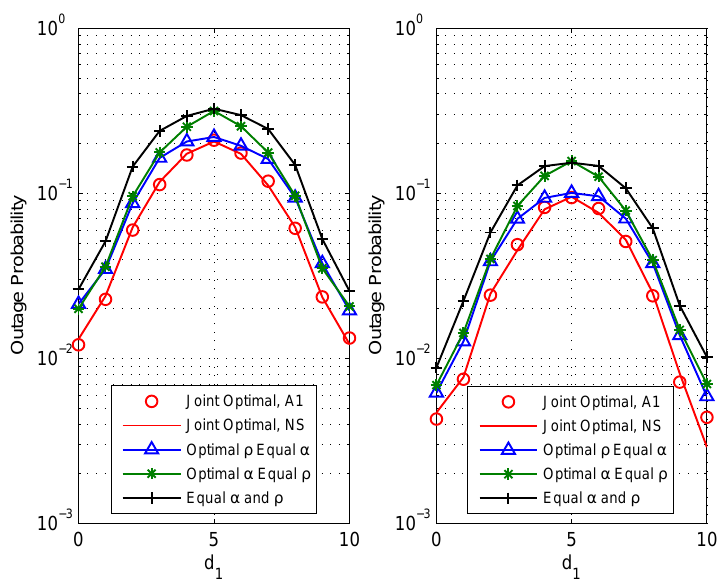
Figure 3. Comparison of the outage performance vs. the distance between source S 1 and relay R ( d 1 ) of different schemes: ( a ) P t = 15 dBm (the left figure); ( b ) P t = 20 dBm (the right figure).